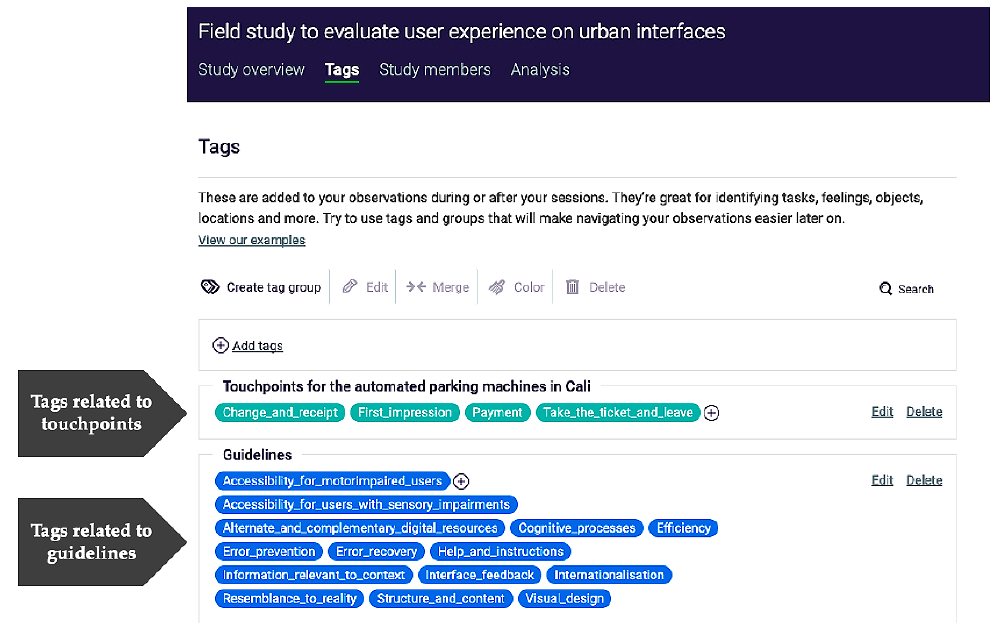
Figure 14. Screenshot of Reframer showing the definition and configuration of tags used for the urban interface of automated parking machines in Cali.